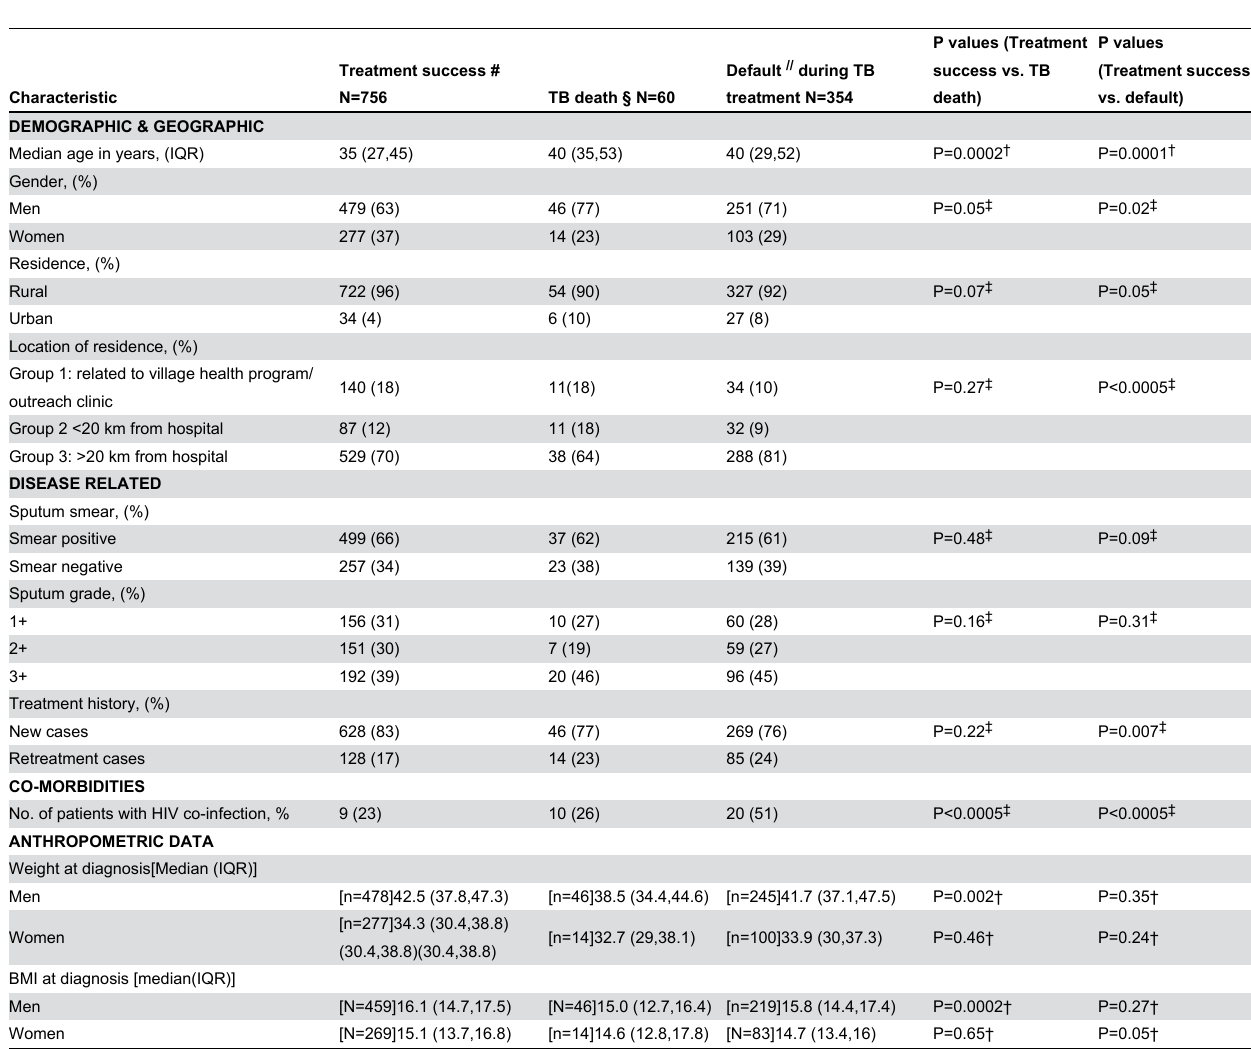
Table 2. Demographic, clinical and anthropometric characteristics of 1179* adult patients with pulmonary tuberculosis who were treated at JSS (2004-2009), stratified by